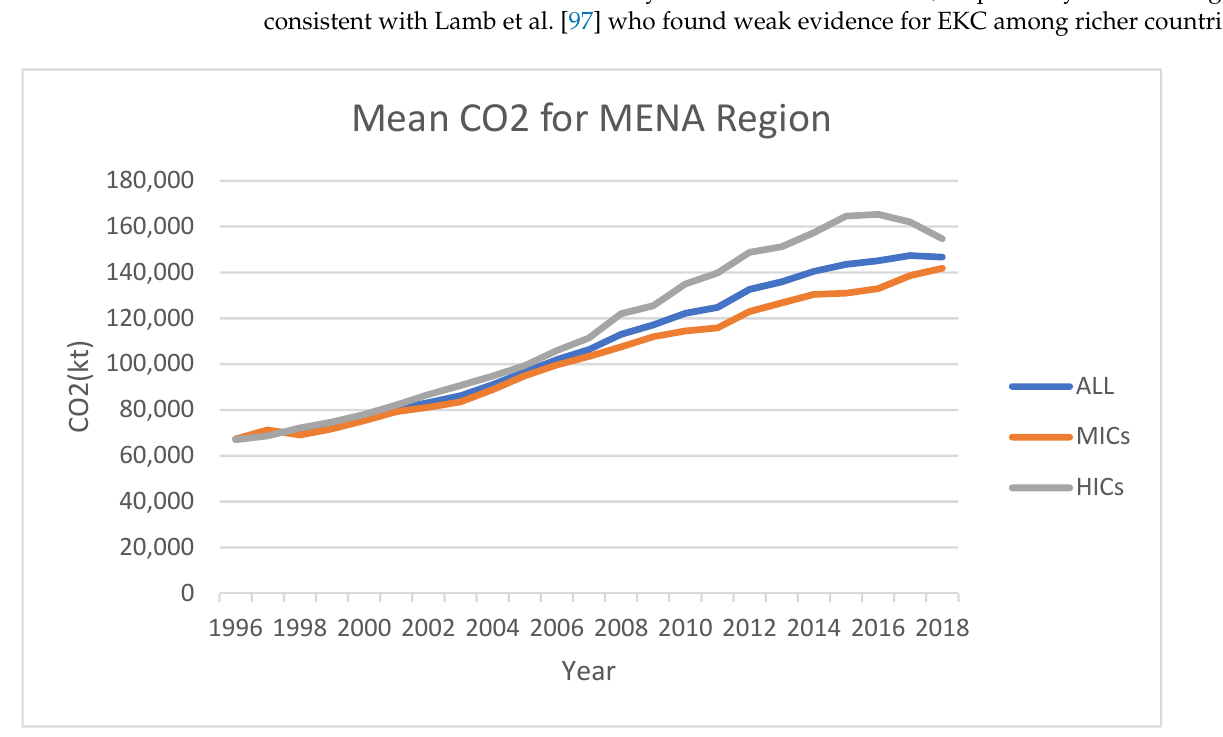
Figure 1. Mean CO 2 for Mean Region.